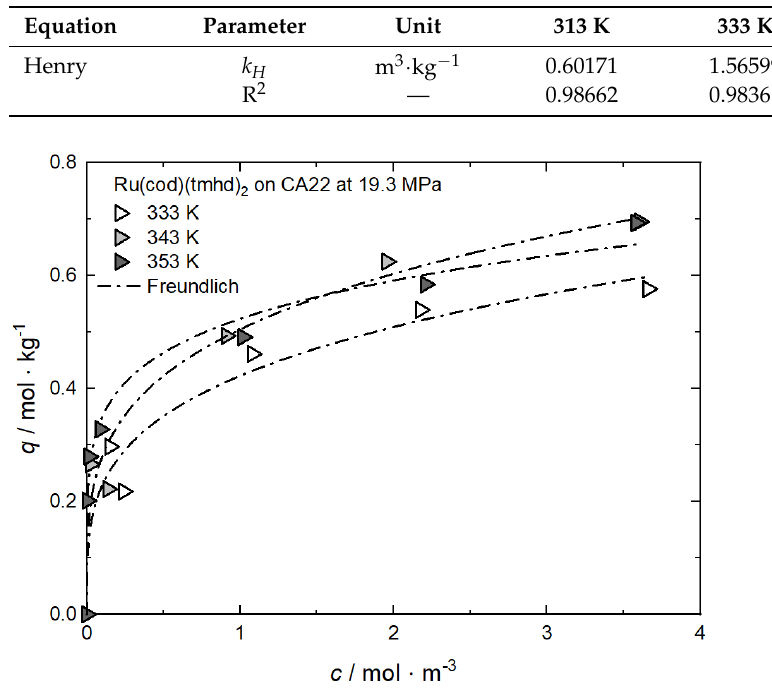
Figure A9. Uptake of Ru(cod)(tmhd) 2 on CA22 at 19.3 MPa and different temperatures; experimental data taken from [63]. Table A9. Adsorption isotherm parameters for Ru(cod)(tmhd) 2 from scCO 2 solution on CA22 at 19.3 MPa and different temperatures [63].